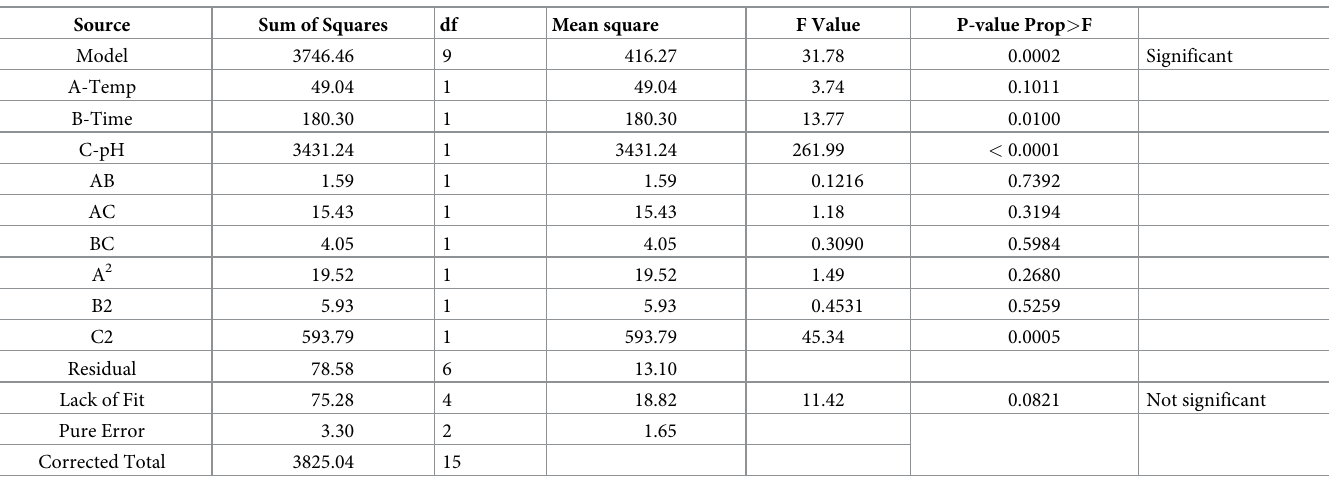
Table 5. ANOVA table for yield (quadratic